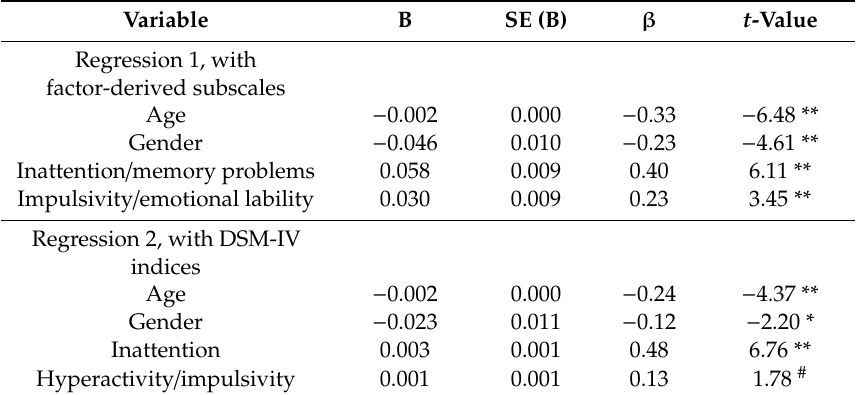
Table 4. Regression coe ffi cients for retained predictors on total criminal thinking ( N = 192). Variable B SE (B) β t -Value Regression 1, with factor-derived subscales Age − 0.002 0.000 − 0.33 − 6.48 ** Gender − 0.046 0.010 − 0.23 − 4.61 ** Inattention / memory problems 0.058 0.009 0.40 6.11 ** Impulsivity / emotional lability 0.030 0.009 0.23 3.45 ** Regression 2, with DSM-IV indices Age − 0.002 0.000 − 0.24 − 4.37 ** Gender − 0.023 0.011 − 0.12 − 2.20 * Inattention 0.003 0.001 0.48 6.76 ** Hyperactivity / impulsivity 0.001 0.001 0.13 1.78